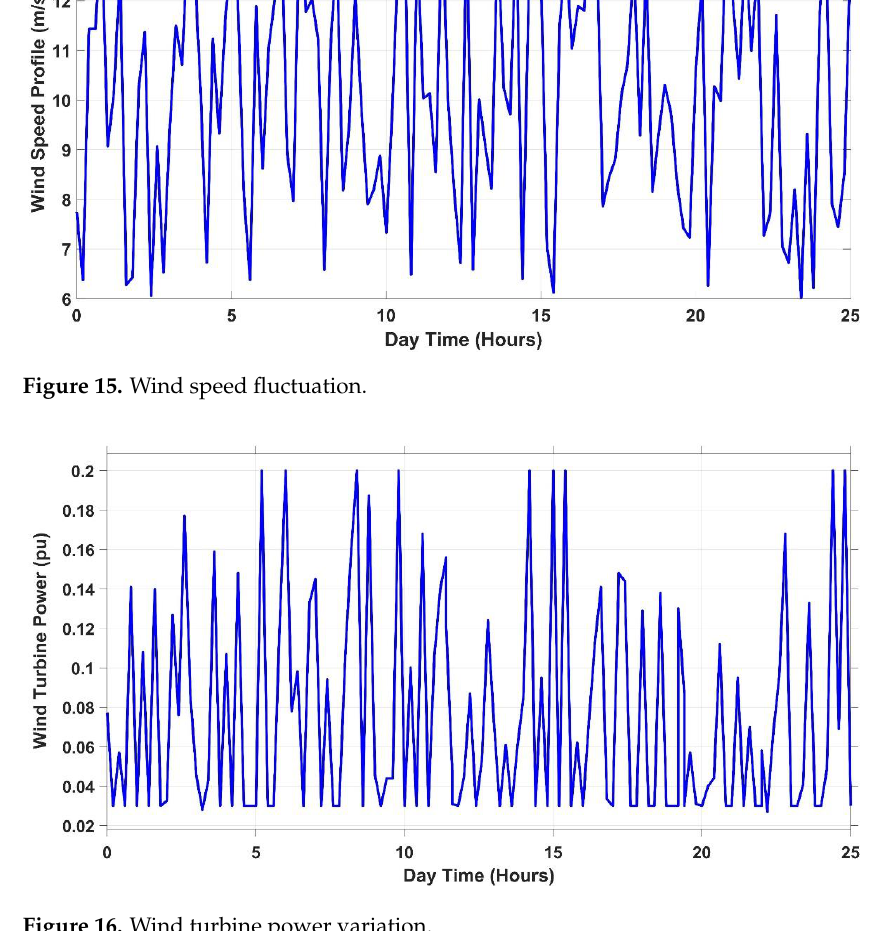
Figure 16. Wind turbine power variation.